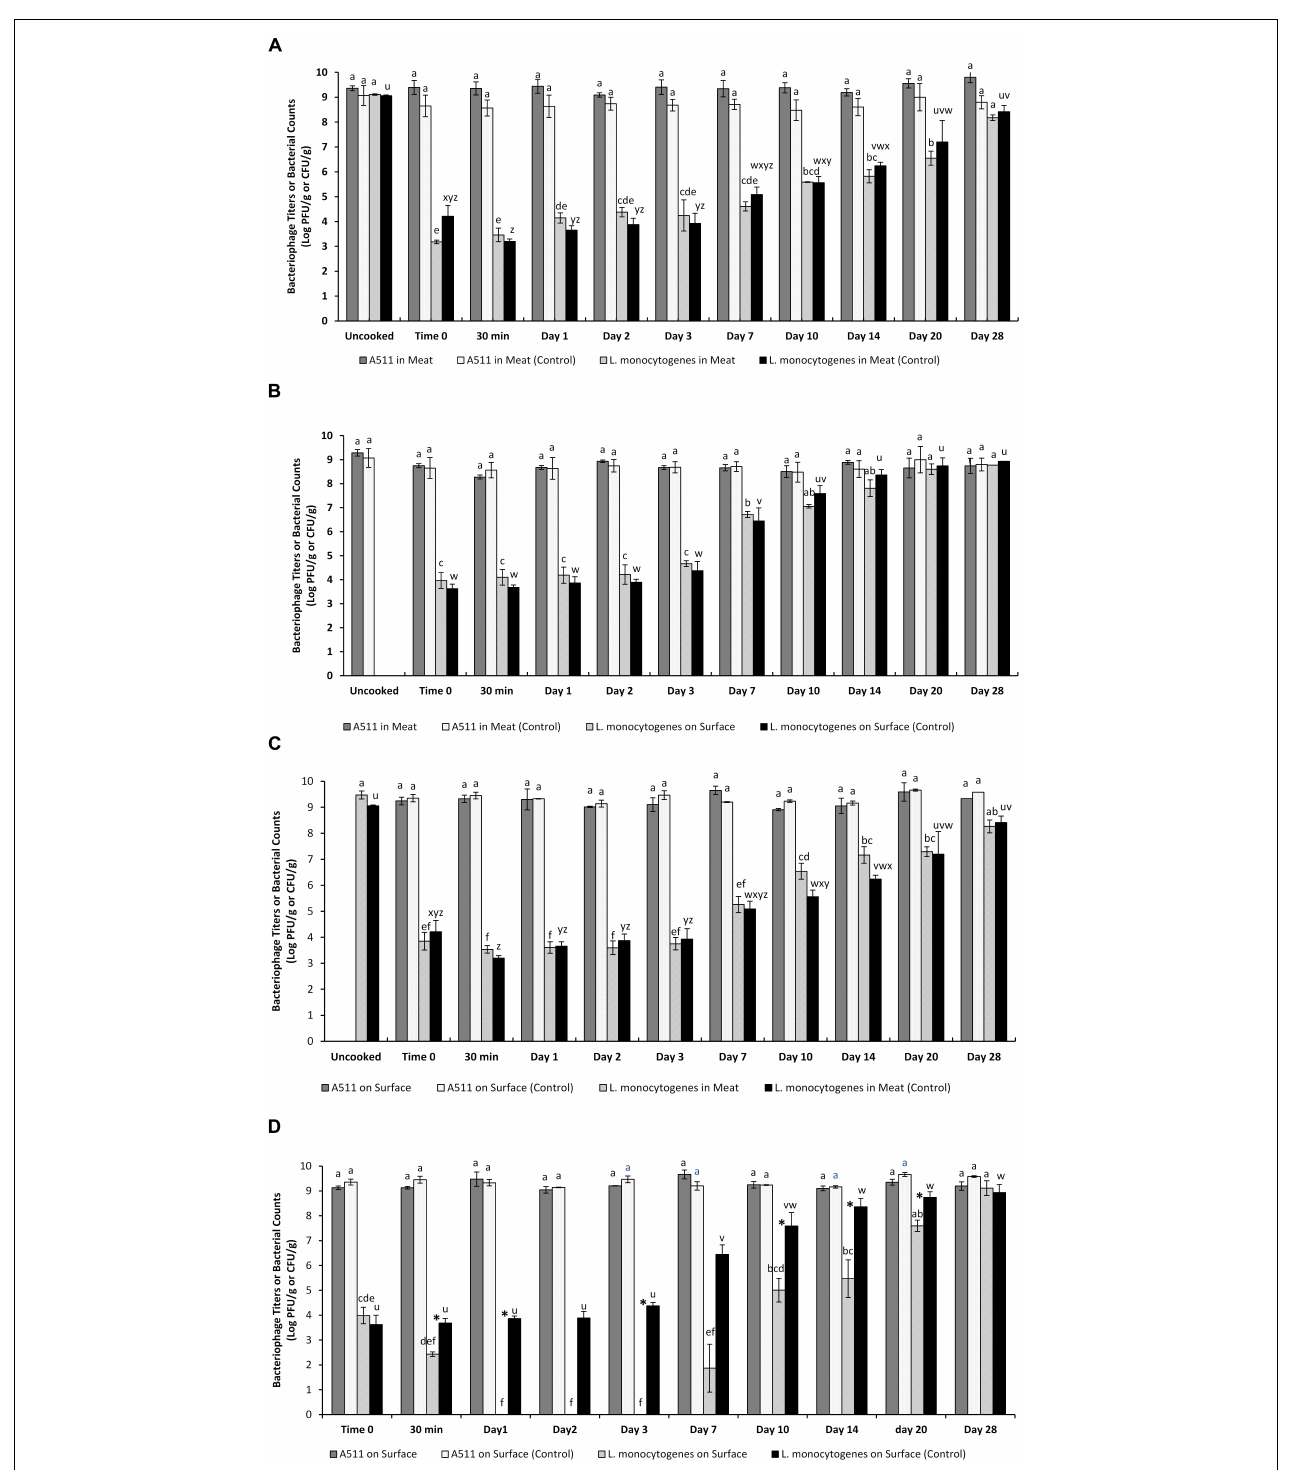
FIGURE 4 | Changes in bacteriophage A511 titers and L. monocytogenes numbers in the vacuum packaged meat slurries prepared following the four different application scenarios and stored at 4 ◦ C for 28 days. (A) A511 and L. monocytogenes added to raw meat slurries and cooked to 65 ◦ C for 21 s; (B) A511 added to raw meat slurries and cooked to 65 ◦ C for 21 s, L. monocytogenes on the surface; (C) L. monocytogenes added to raw meat slurries and cooked to 65 ◦ C for 21 s, A511 on surface; (D) A511 and L. monocytogenes on surface of cooked meat slurries. Different letters above bars indicate significant differences ( P < 0.05) between mean bacterial counts or bacteriophage titers in the meat slurries of the same treatment at predetermined time intervals. Data are means from three